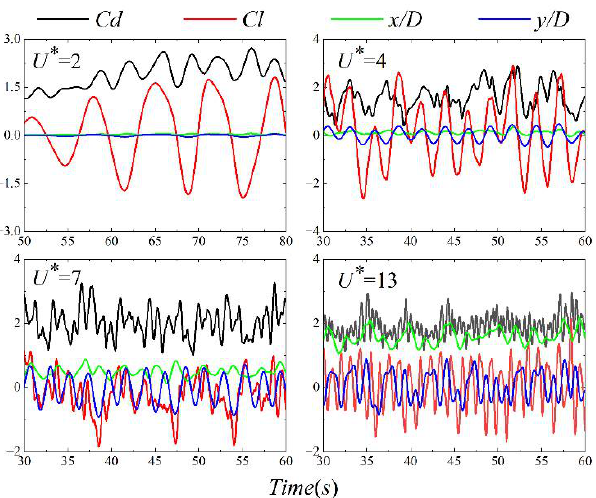
Figure 15. Motion trajectories for a cylinder with different coverage ratios.